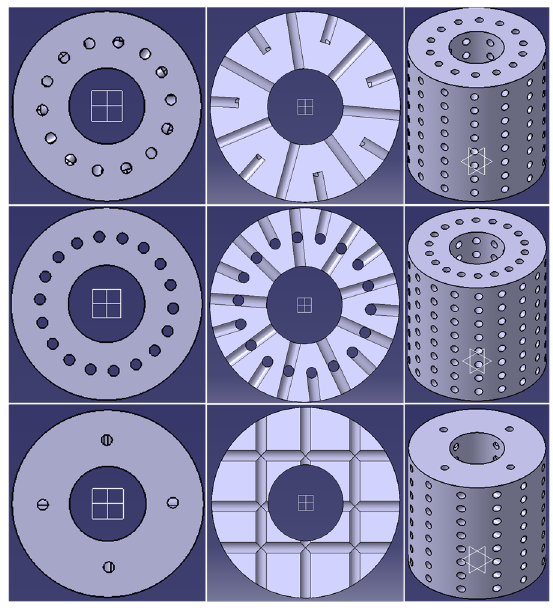
Figure 1. Top view (left column), cross sectional view (middle column), and isometric view (right column) of scaffolds with different pore distributions. Pore distributions are identified in yellow in the corresponding line.